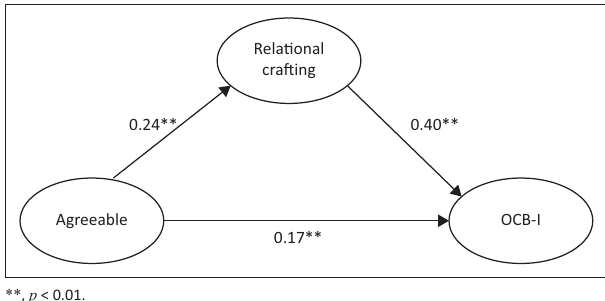
FIGURE 3: Path diagram between agreeableness, relational crafting and organisational citizenship